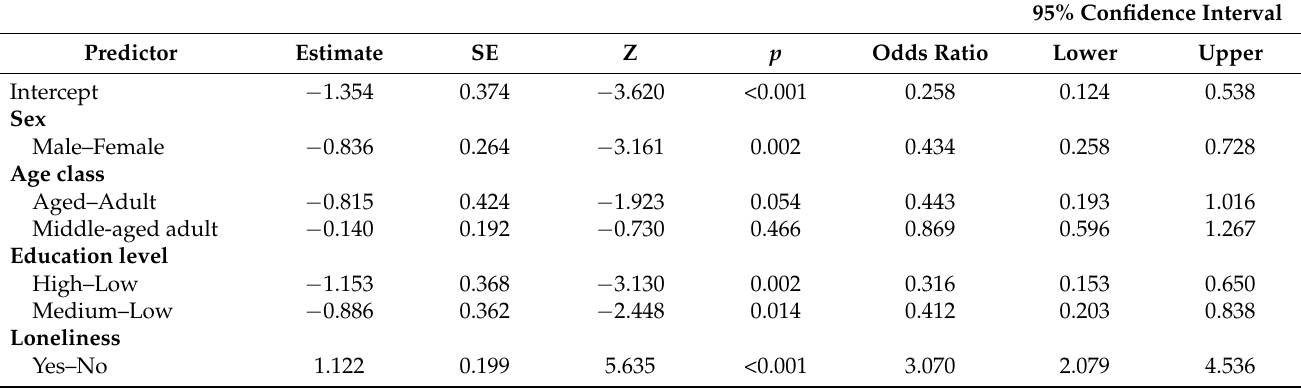
Table A8. Results of Multivariate Regression Analysis Models, with Quality of Sleep as Dependent Variable and Feeling of Loneliness and Sociodemographic Characteristics as Independent